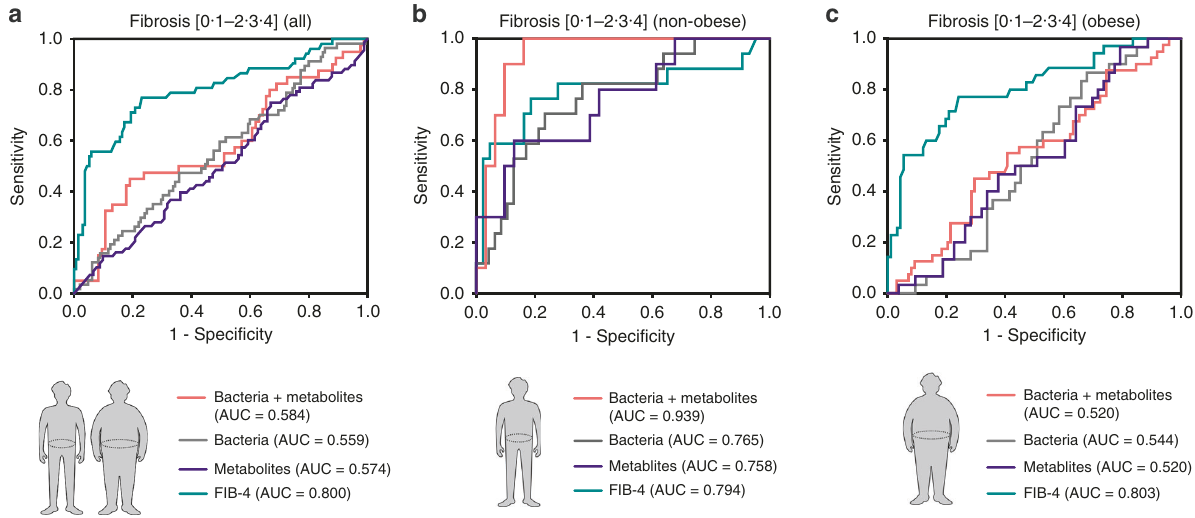
Fig. 5 Receiver-operating characteristic (ROC) curves for the diagnosis of signi fi cant fi brosis in all, non-obese, and obese subjects. ROC curves using the combination of two bacteria ( Veillonellaceae and Ruminococcaceae ) and four stool metabolites (CA, CDCA, UDCA, and propionate) were plotted for the diagnosis of signi fi cant fi brosis in a all, b non-obese subjects, and c obese subjects, and the areas under the ROC curves (AUCs) were calculated. FIB-4, fi brosis 4 index.